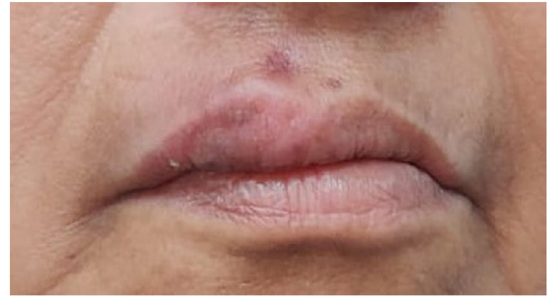
Fig. 5 Postoperative photo (1 week after removal of the tooth